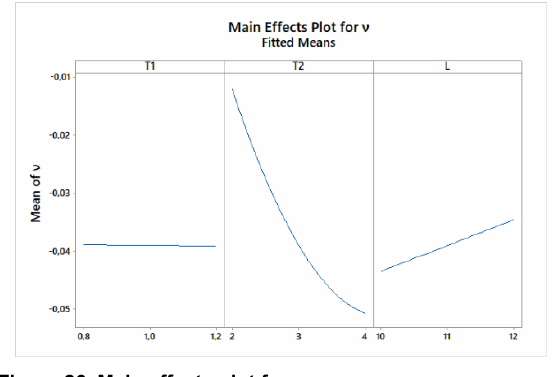
Figure 26. Main effects plot for v Table 5. Levels of the action parameters needed to obtain the objectives on evaluation parameters Levels of action parameters needed